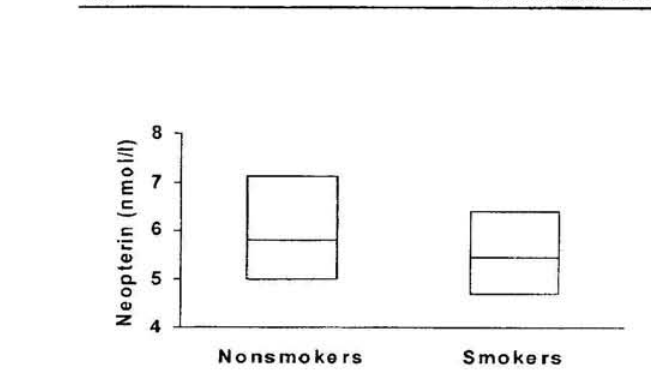
Figure 3. Box and Whiskers plots of serum neopterin concentrations of nonsmokers and smokers. The box extends from the 25 lh percentile to the 75"' percentile, with a horizontal line at the median (50"' percentile). The median neopterin concentration of the nonsmo- kers' group is higher (p <0.0001) compared to the smokers'